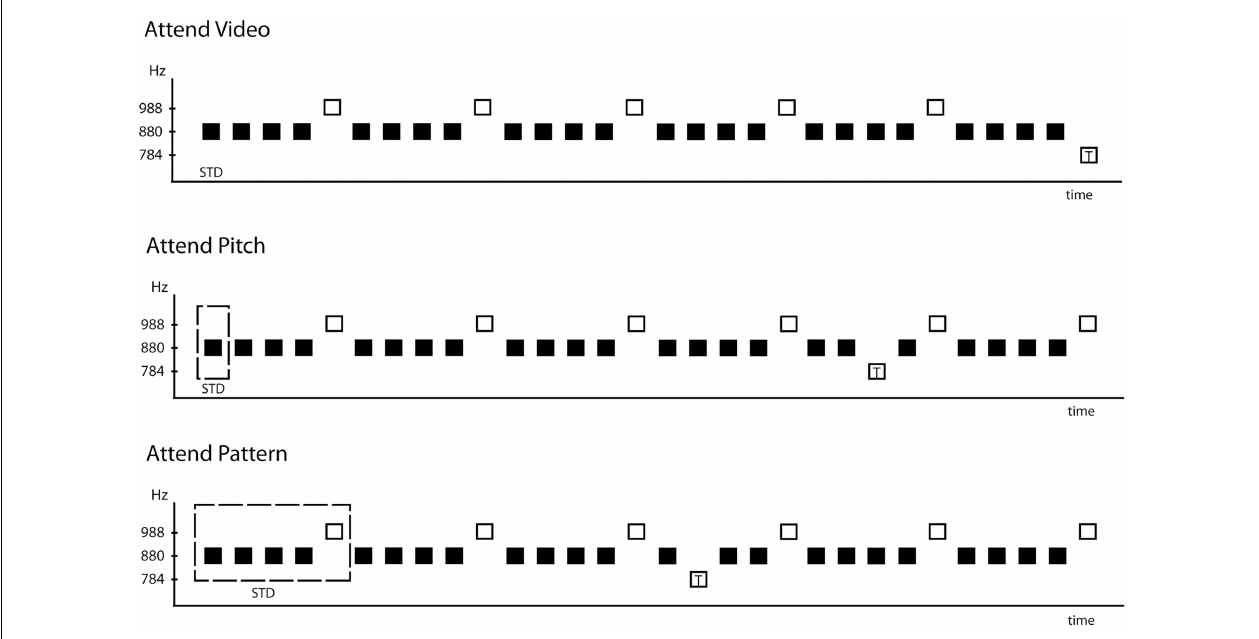
row), and Attend-Pattern (bottom row).Target tones are represented by the open square with a “T” inside.The position of the target shown in each condition denotes that the target occurred randomly (2%), whereas the other tones were presented in a fixed order.The dashed square outlines the smallest tonal element needed to perform the task, thus denoting the standard used in the MMN deviance detection